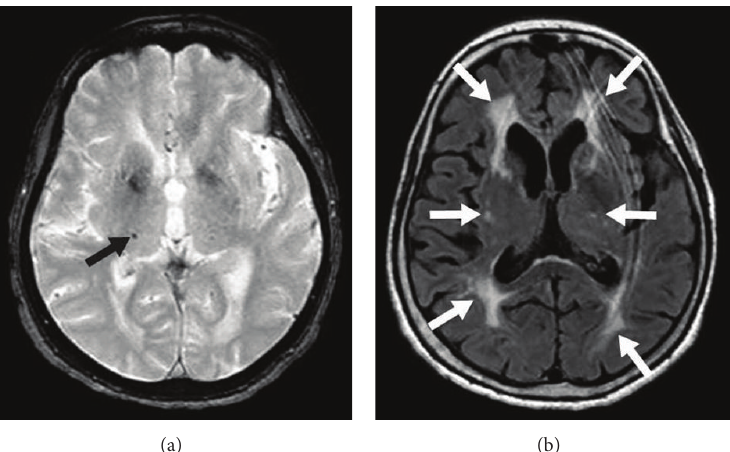
Figure 5: Gradient-echo (a) and FLAIR (b) sequences showing a right-sided thalamic microbleed (a) associated with diffuse ischemic white matter hyperintensities on FLAIR imaging (b) in a patient with severe and chronic arterial hypertension.